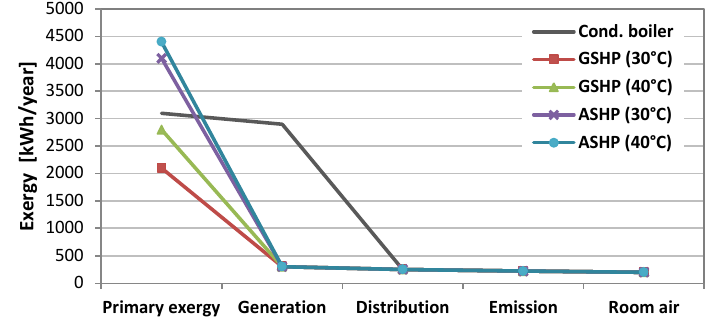
Figure 4. Exergy flows through the components for different heat generation systems [20].